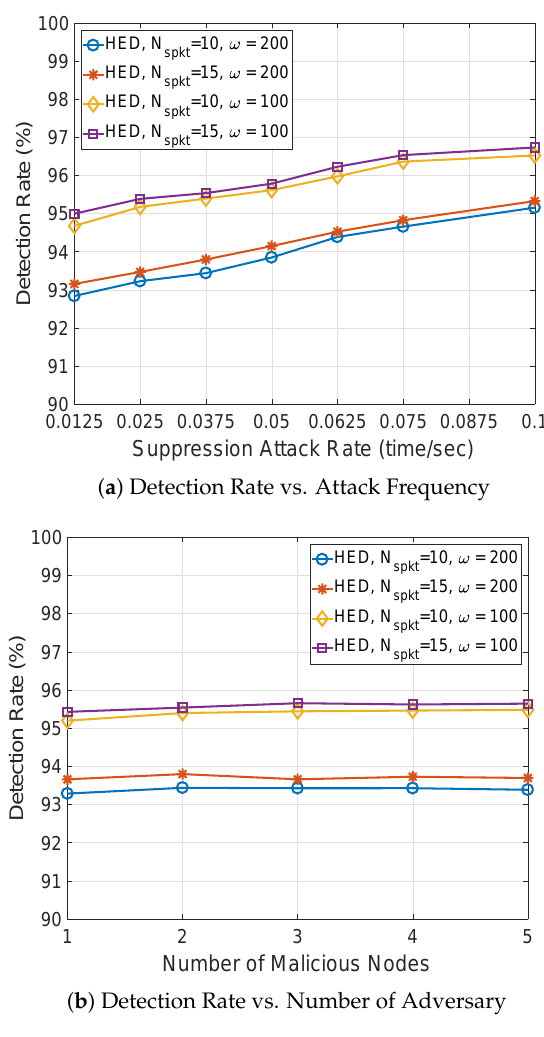
Figure 7. The detection rate against suppression attack rate and number of malicious